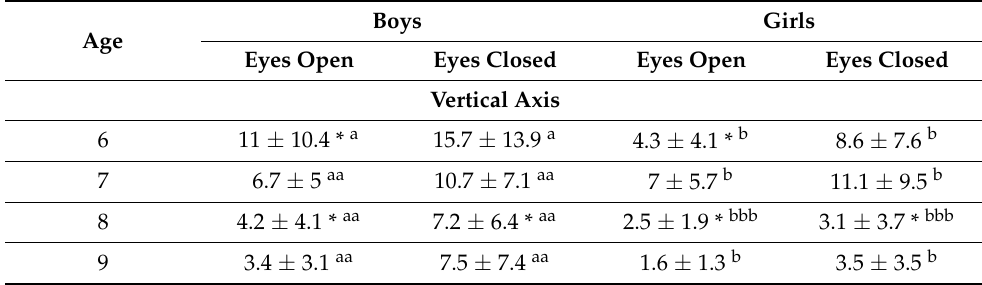
Table 2. Average acceleration during monopodal test with eyes open and eyes closed (mean ± standard